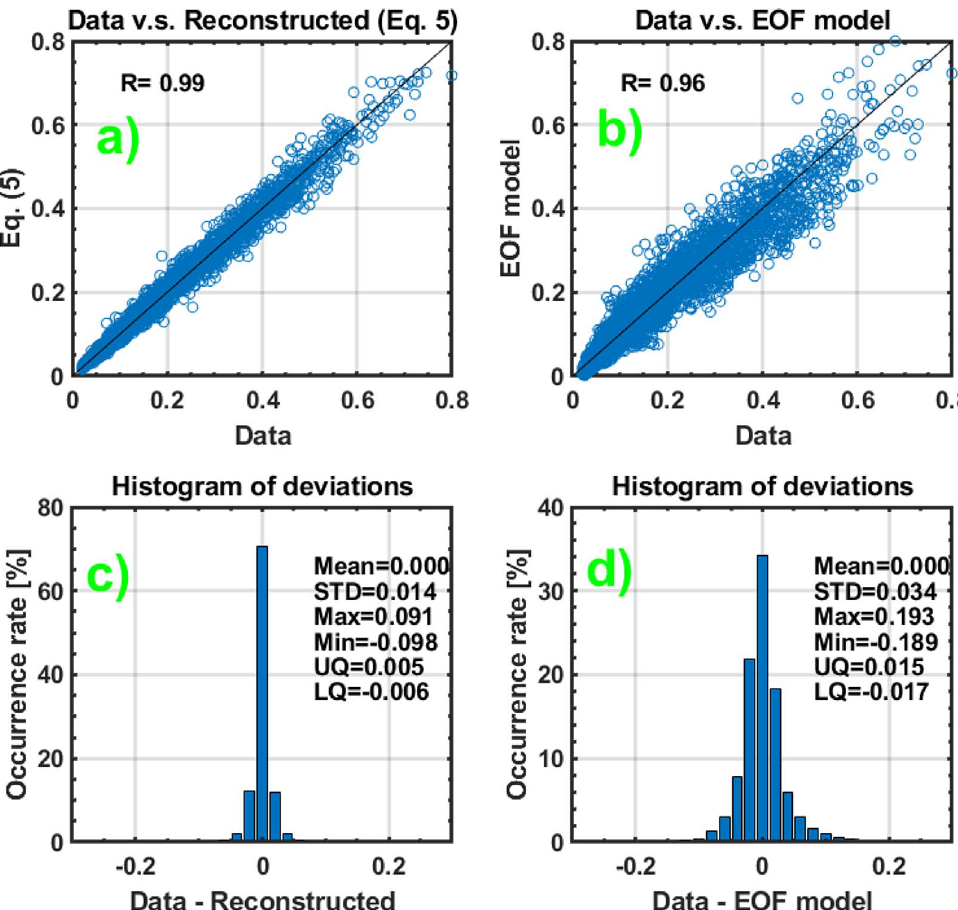
Fig. 8. The comparison of (a) reconstructed ROTI climatology using equation (5) and (b) EOF model versus the GPS ROTI data. The histogram of the bias (Data – Model) using equation (5) (c) and EOF model (d) in a bin step of 0.02 TECU/min. UQ = upper quartile; LQ = lower